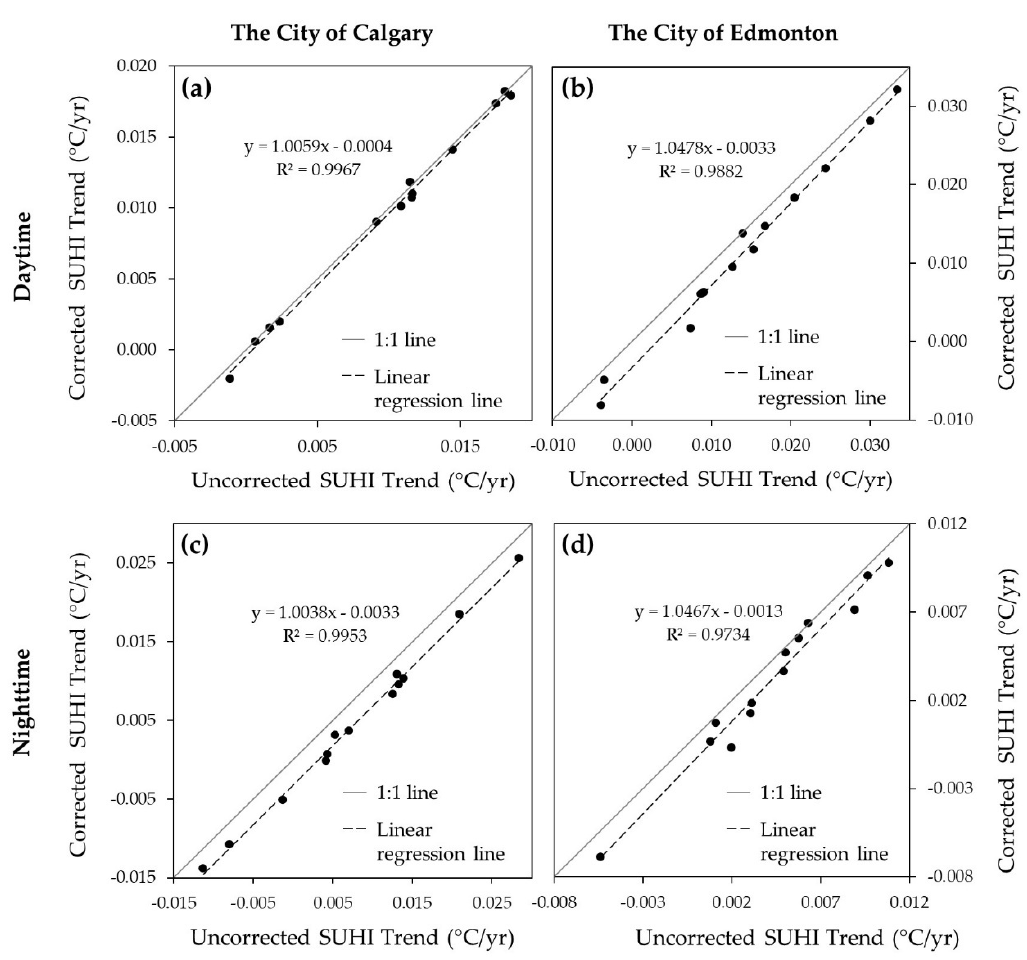
Figure 4. Linear regression between the SUHI trends derived from terrain corrected LST and uncor- rected LST during daytime ( a , b ) and nighttime ( c , d ) for Calgary ( a , c ) and Edmonton ( b , d ) during 2001–2020. Table 1. Monthly and annual day and nighttime SUHI trends ( ◦ C/yr) during 2001–2020 in the cities of Calgary and Edmonton. The significant values are in italics, where *, **, and *** indicate the 90, 95, and 99% confidence levels,